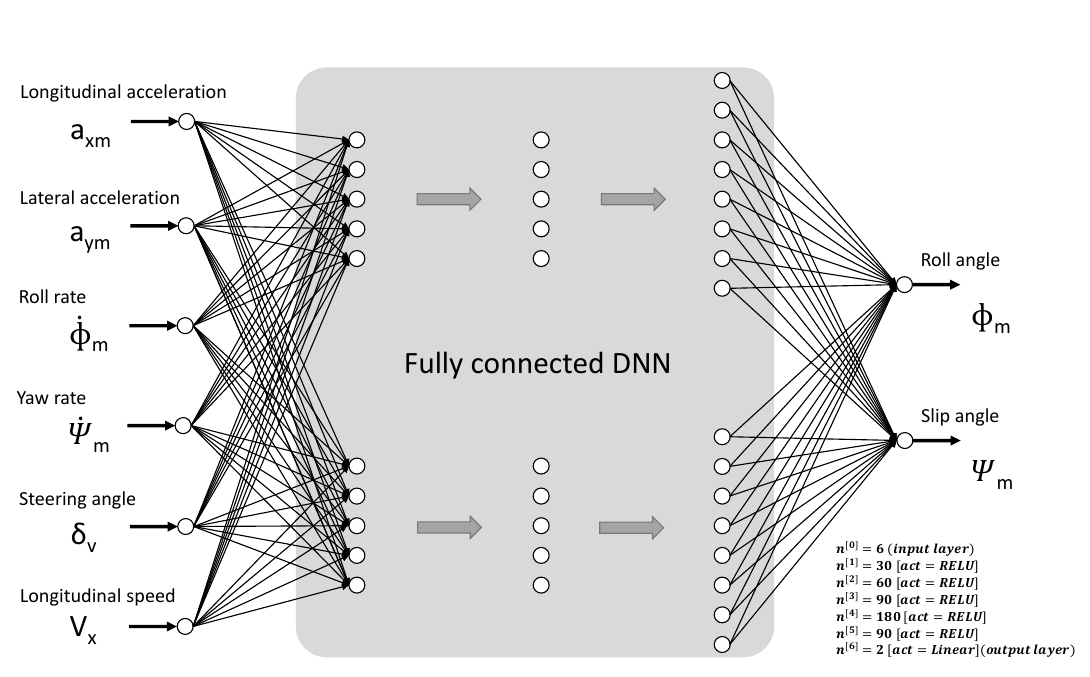
Figure 3. Deep Neural Network configuration